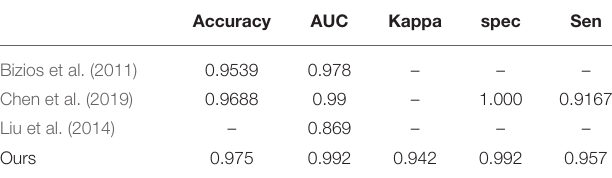
TABLE 7 | Comparison of analogous approaches.